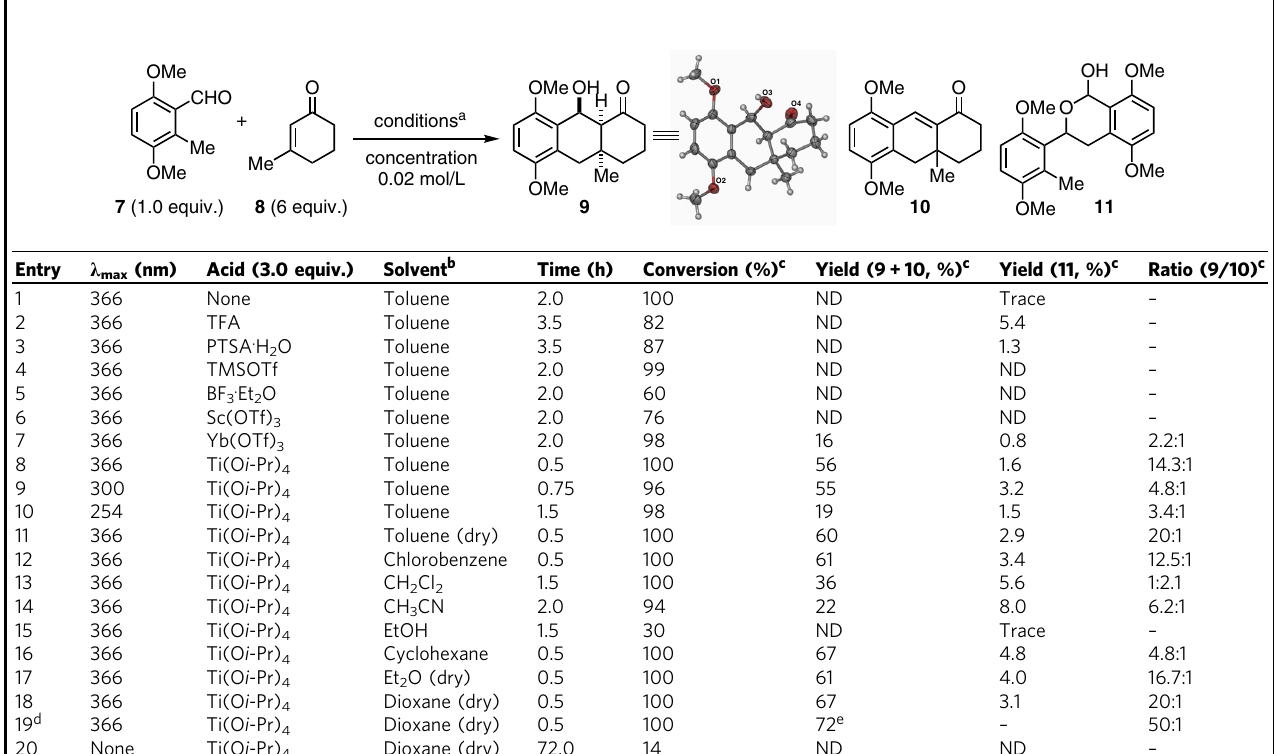
Table 1 Condition screening of